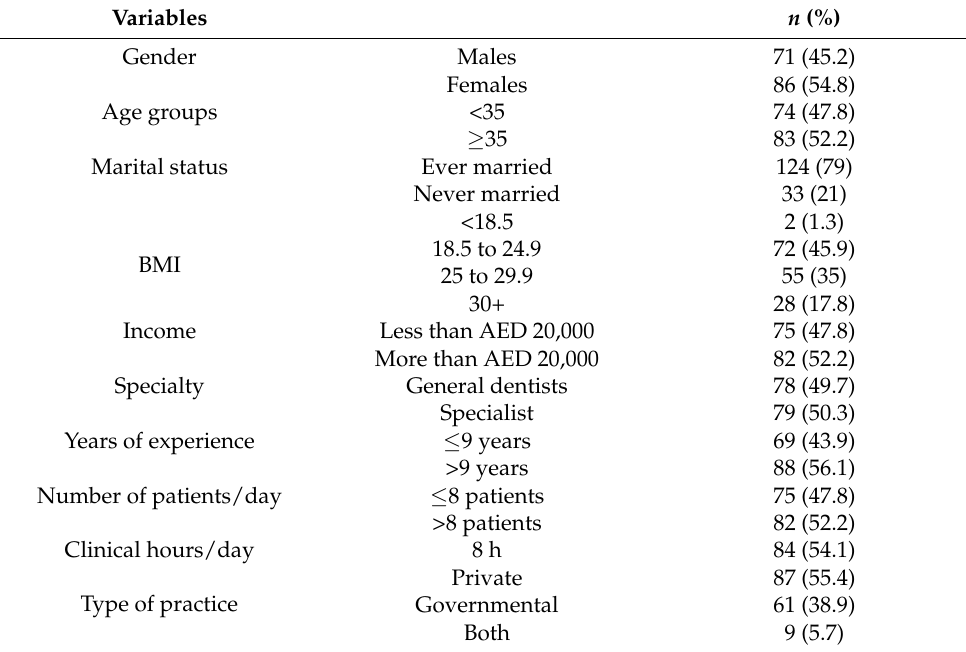
Table 1. Sociodemographic and other characteristics of the study population ( n =